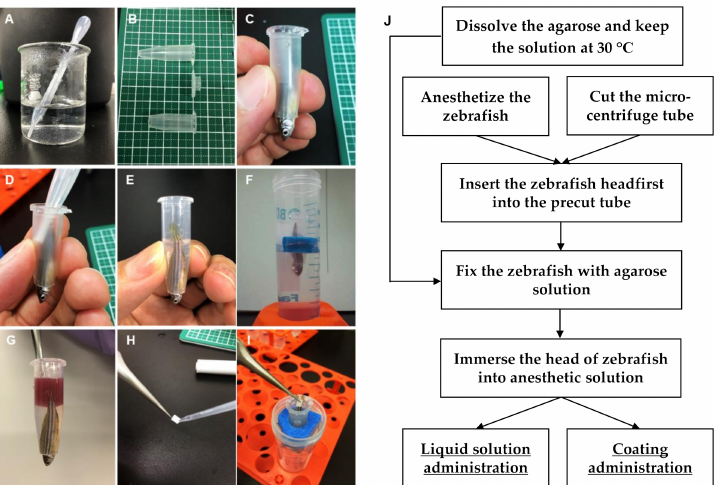
Figure 4. Procedure for transdermal administration in adult zebrafish. ( A ) Dissolved 3% agarose solution; ( B ) A 1.5 mL micro-centrifuge tube with the tip cut o ff up until approximately 10